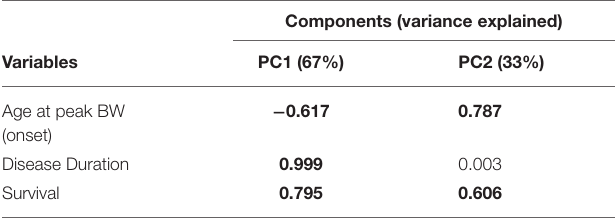
TABLE 2 | Principal component analysis on SOD1G93A mice disease-related data.